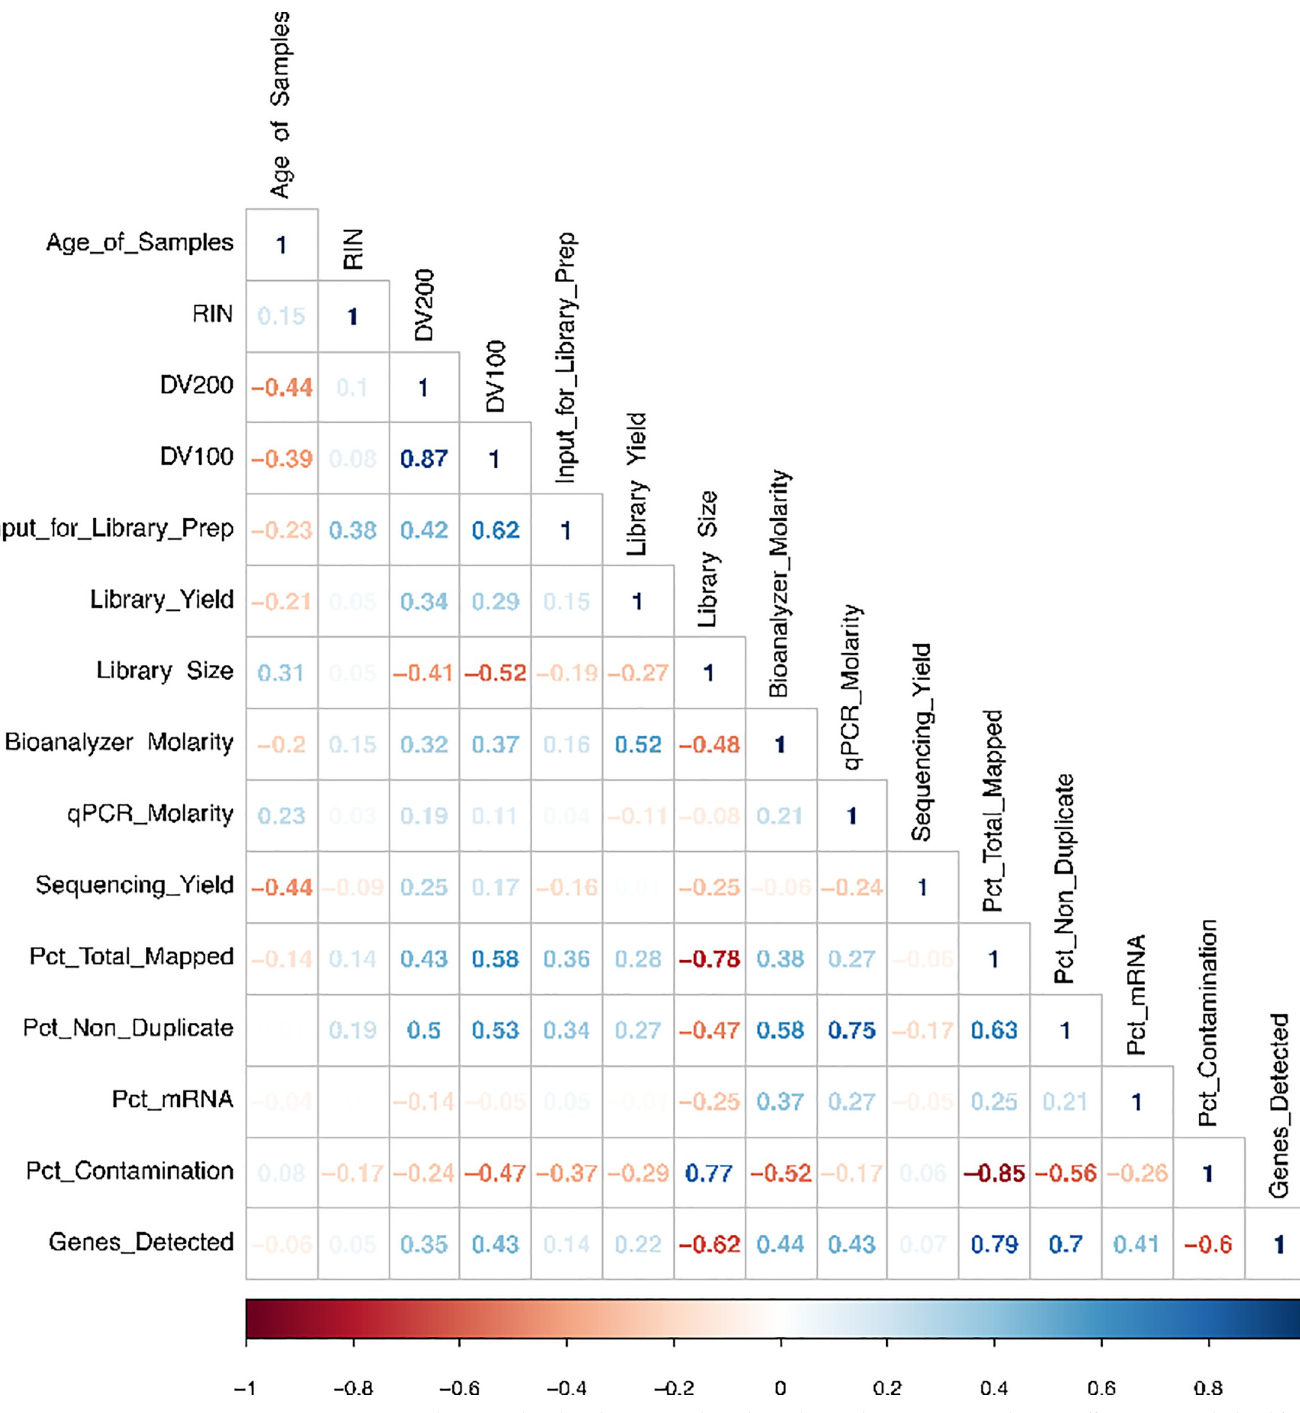
Fig 2. Correlations analysis based on QC results. Correlations analysis based on QC results and sample metadata. Pearson correlation coefficients were calculated for a matrix of the various parameters examined in this study; the correlation matrix using the R package corrplot. The parameters included in the matrix were: age of samples in years (Age of Samples), RIN, DV 200 , DV 100 , library input of starting material (Input_for_Library_Prep), Bioanalyzer measurement of library yield in ng (Library_Yield), library size in base pairs (Library Size), molarity of the libraries in nM (Bioanalyzer Molarity), qPCR molarity, sequencing yield, total percentage of mapped reads to human (Pct_Total_Mapped), total percentage of non-duplicate mapped reads (Pct_Non_Duplicate), percent mRNA bases mapped to human (Pct_mRNA), total percentage of mapped reads to bacterial and mouse genomes (Pct_Contamination), and total number of genes which have more than 5 read mapped (Genes_Detected). Positive correlations are displayed in blue and negative correlations in red color. Color intensity is proportional to the correlation coefficients. In the bottom of the correlogram, the legend color shows the correlation coefficients and the corresponding colors. Values between 0.7 and 1.0 (-0.7 and -1.0) indicate a strong positive (negative) linear relationship. Samples with NA values were